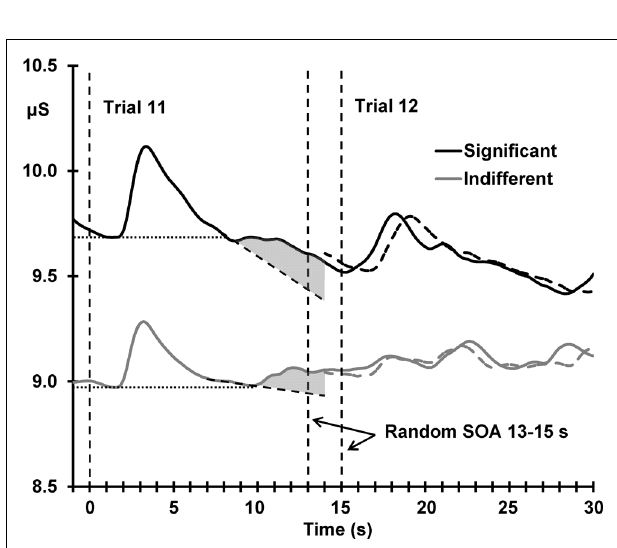
FIGURE 6 | Mean unbaselined electrodermal activity from 1 s preceding deviant stimulus onset, separately for the two conditions. Vertical dashed lines represent stimulus onset; note the two dashed lines marking the variable onset of trial 12 due to the random SOA (13–15 s).The dashed waveforms represent the average unbaselined activity from the onset of trial 12; the slight shift in the latency of the response peak is directly related to the variable SOA.The horizontal dotted lines demonstrate the complete resolution of the SCR to the deviant stimulus for both conditions, and the diagonal dashed lines represent the continuation of this response.The shaded area illustrates the sensitization process.